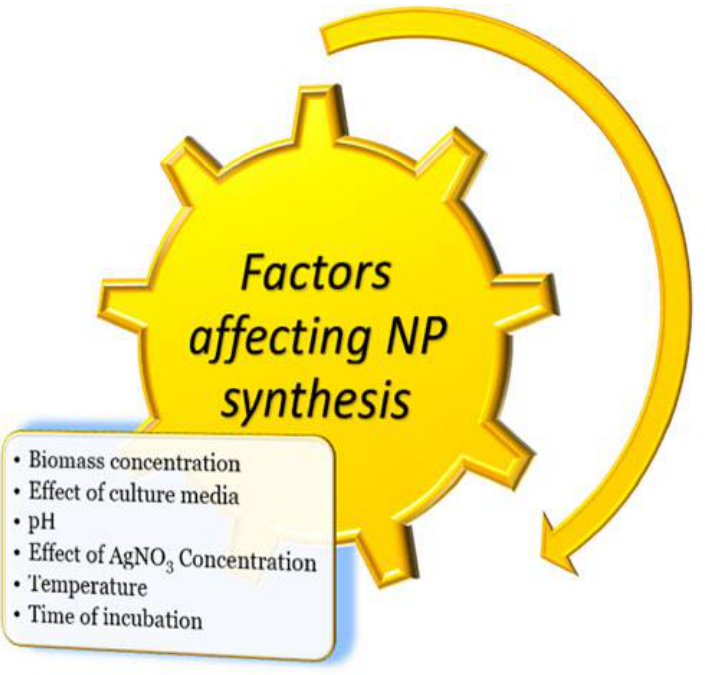
Figure 1. Factors that have an effect on the synthesis of metallic nanoparticles (adapted from [21]). The term nano-remediation currently refers to the application of nanotechnology that contains the use of fabricated nanomaterials to clean contaminated phases such as air, soil and water, groundwater, and polluted/wastewater [22,23]. Well-established technology holds potential and efficacy, but full-scale applications have some drawbacks to overcome. Engineered nanomaterials (ENMs) have many strange features such as size, shape, energy surface, and chemical core, showing sustainability that affects their end properties, and seawater reflects their released complex properties